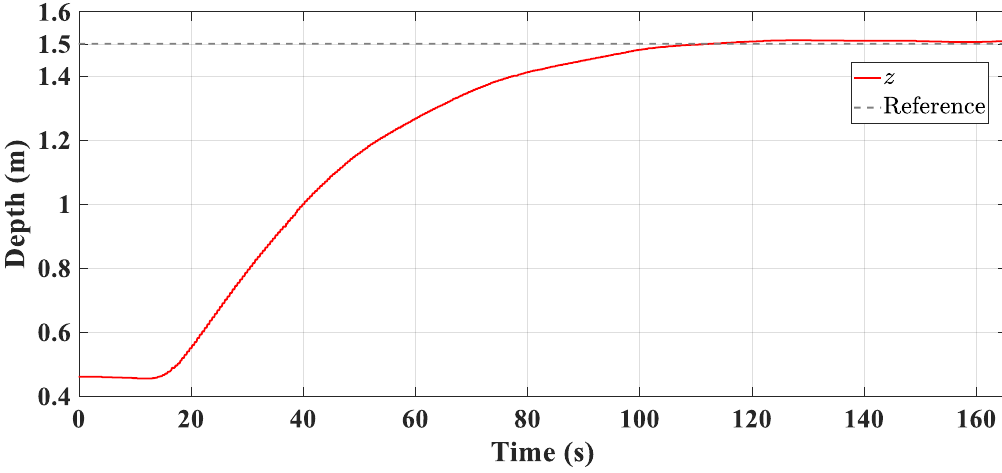
Figure 13. Depth response of hovering control via on-off type VBS.